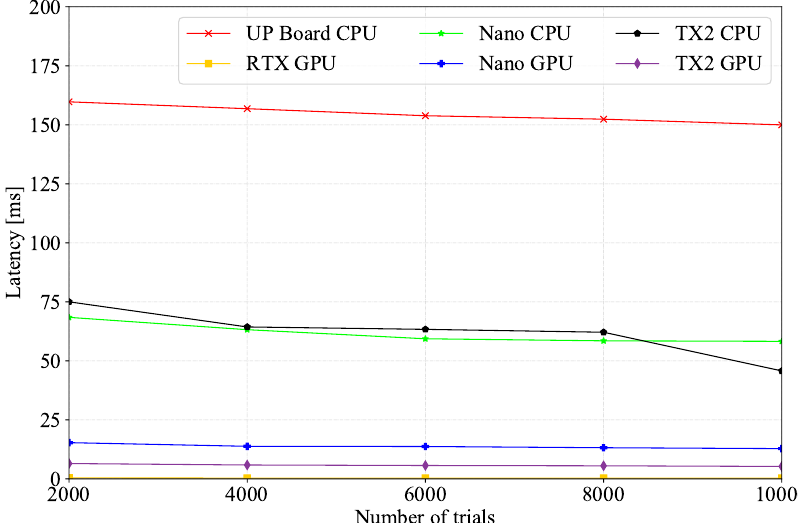
Figure 16. Comparison of the latency under different tuning times.